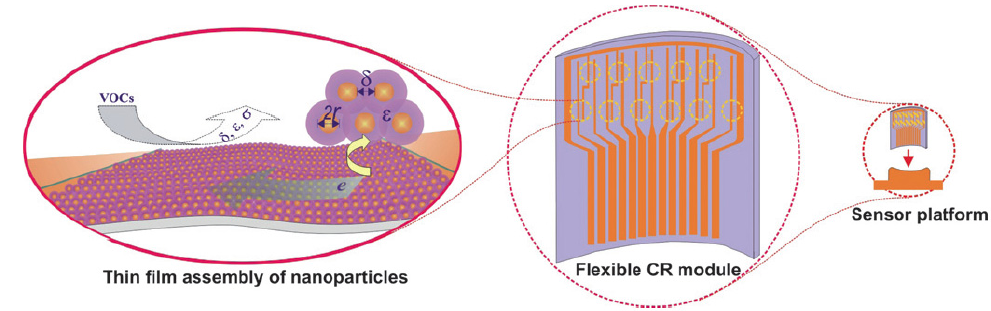
Figure 17. Illustrations of a chemiresistor (CR) sensor array of patterned microelectrodes